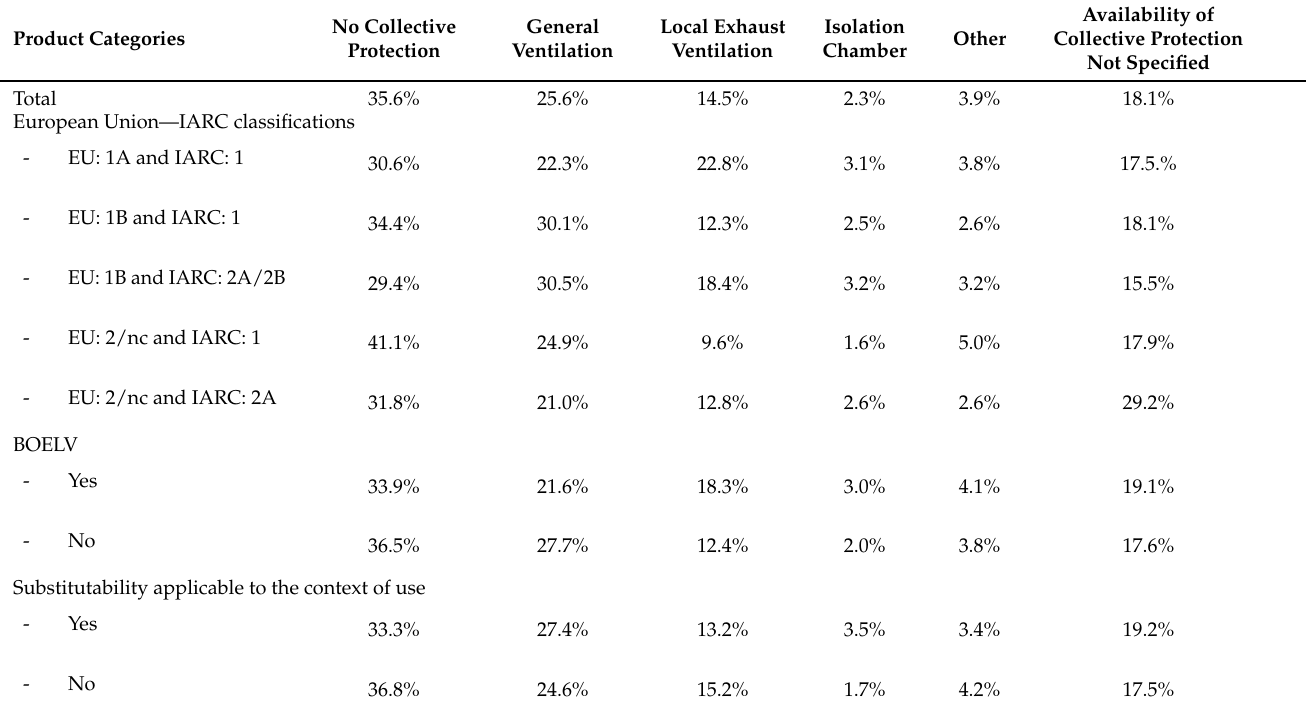
Table 2. Implementation of collective protections and